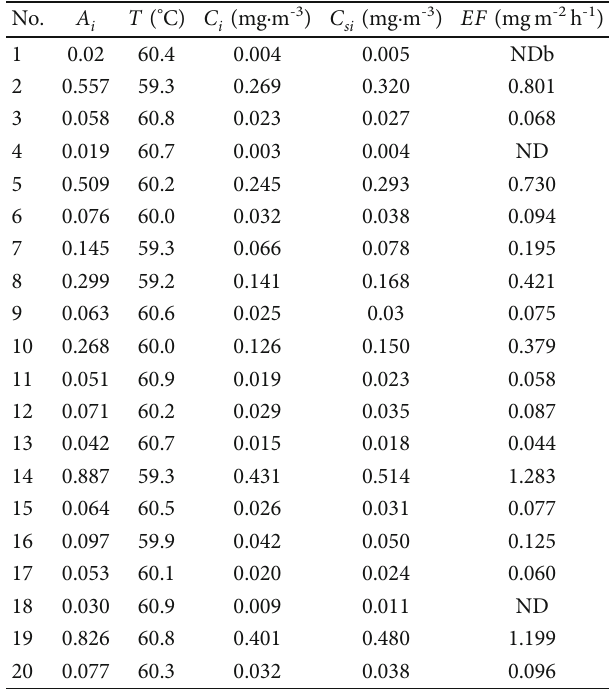
Table 1: Summary of formaldehyde emission parameters for synthetic rubbers